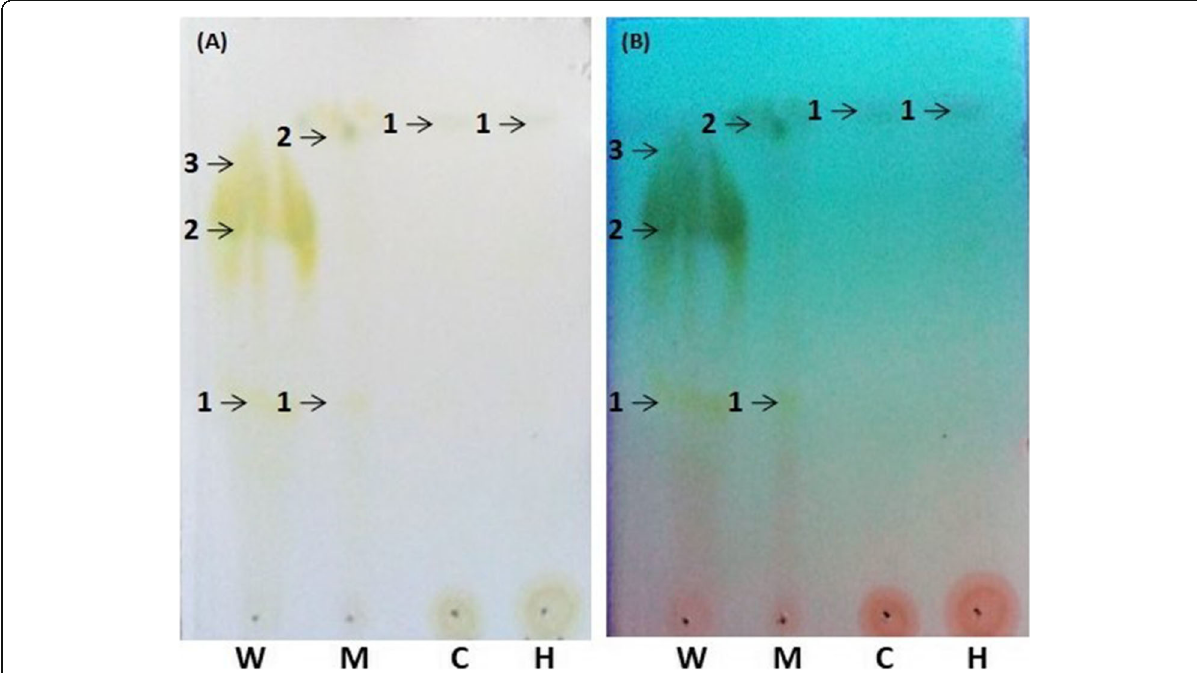
Fig. 1 Thin layer chromatograph of aqueous (W), methanol (M), chloroform (C), and n -hexane (H) extracts of fresh papaya flowers. a Visualization in visible region. b Visualization in UV-region (254